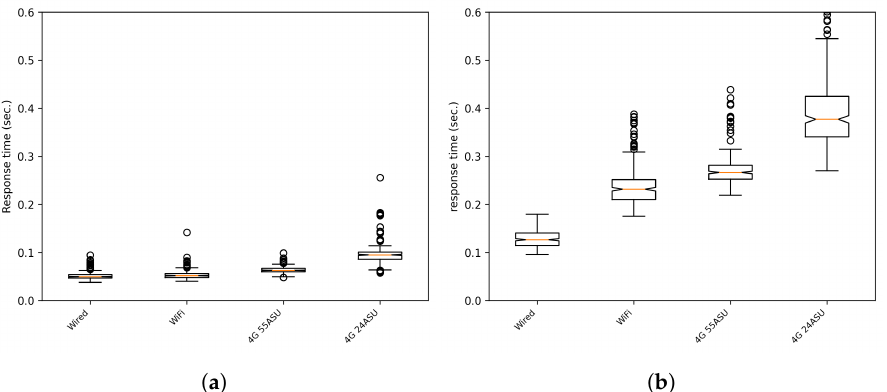
Figure 5. Response times for static clients with either UDP or HTTP and for different types of network connections. In these tests, there were no outdated messages. ( a ) UDP; ( b ) HTTP. ASU, arbitrary strength unit.